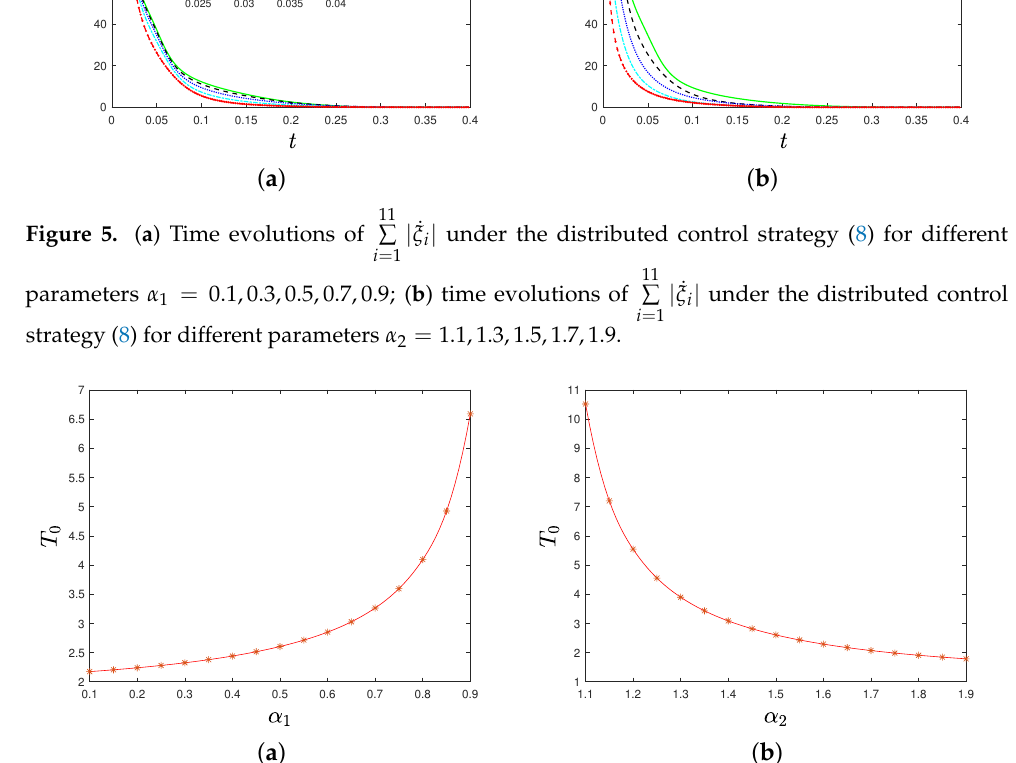
Figure 4. ( a ) Time evolutions of parameters α 1 = 0.1,0.3,0.5,0.7,0.9; ( b ) time evolutions of strategy (6) for different parameters α 2 = 1.1,1.3,1.5,1.7,1.9.